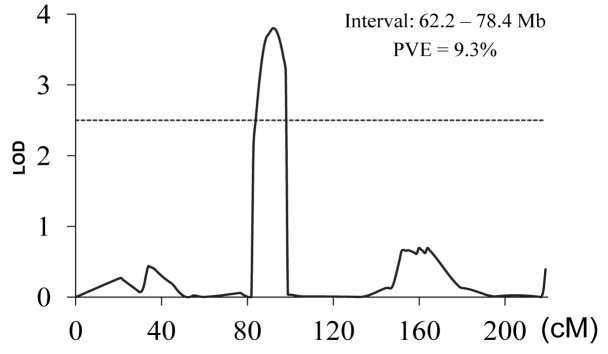
Validation of head smut resistance QTL q5.03HR with a BC4F1 population.